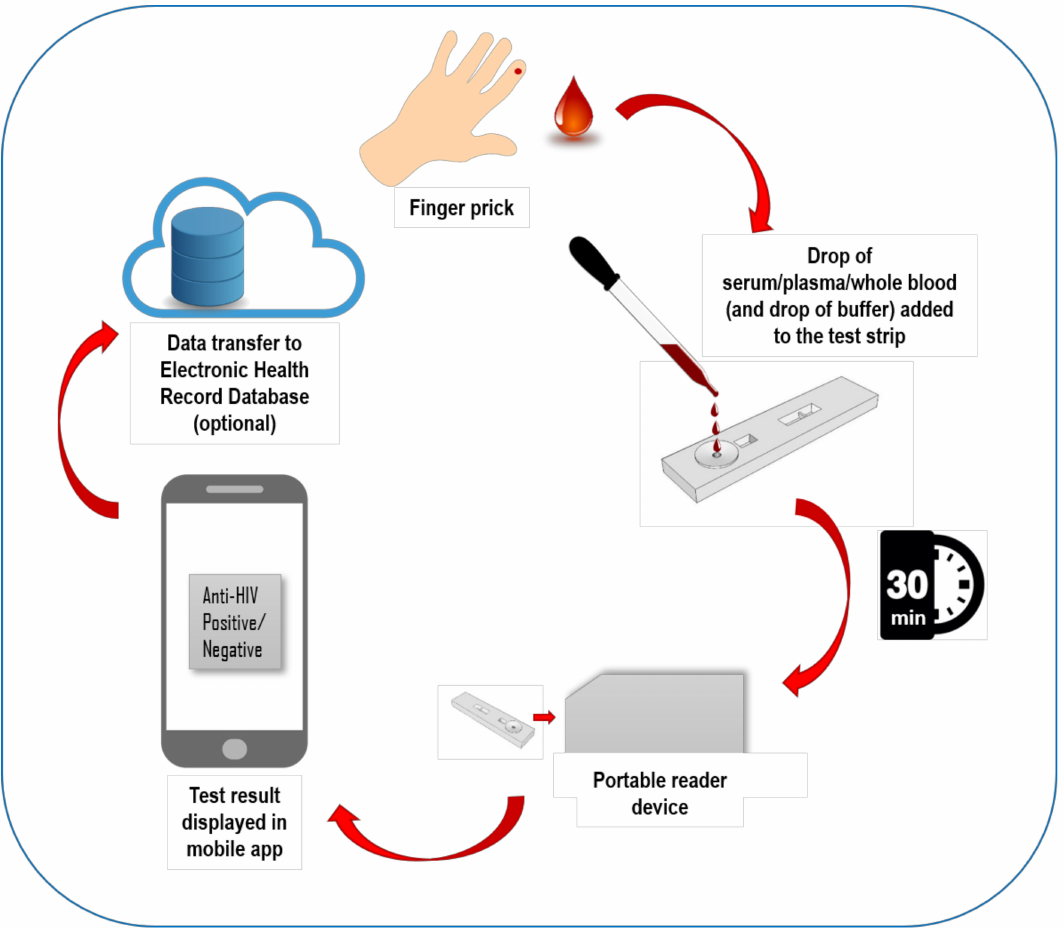
Figure 1. Schematic illustration of the ideal technology components and workflow of the upconverting nanoparticle (UCNP) reporter-based lateral flow assay